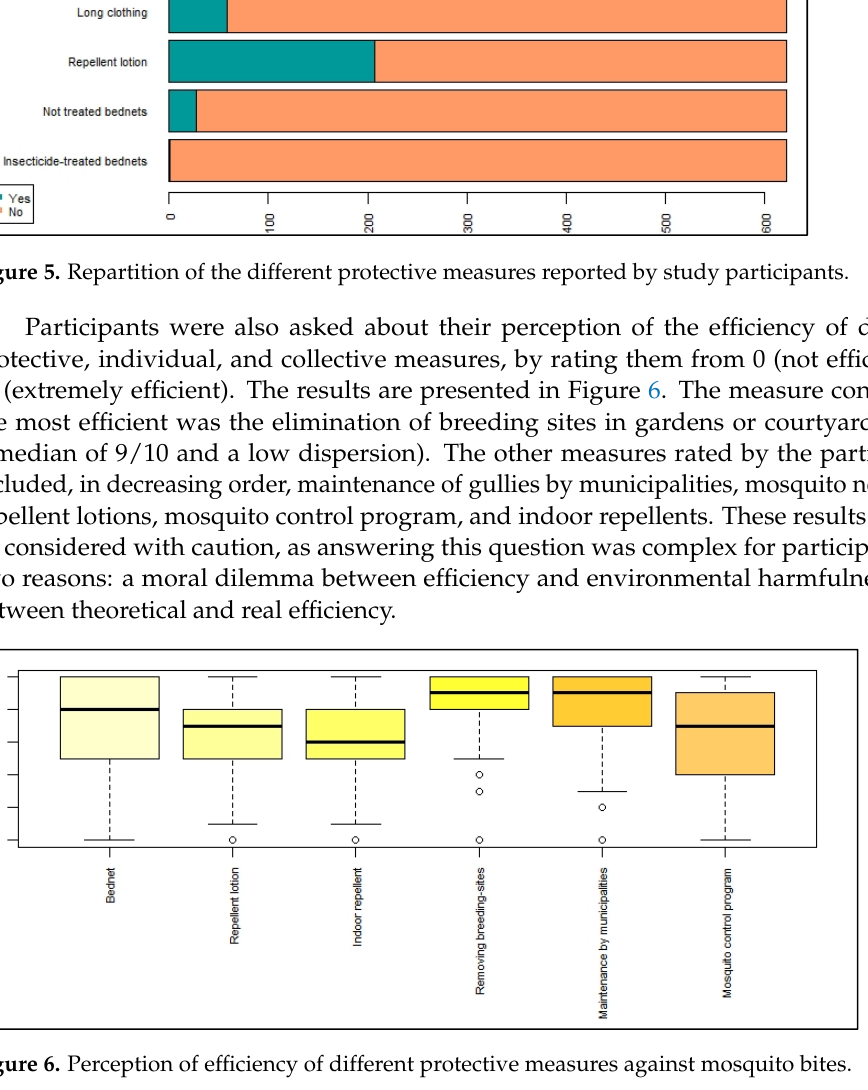
Table 4. Cross analysis between use of protective measures, socio-demographic characteristics, ex- perience of a dengue-like symptoms, and perception of severity or risk.